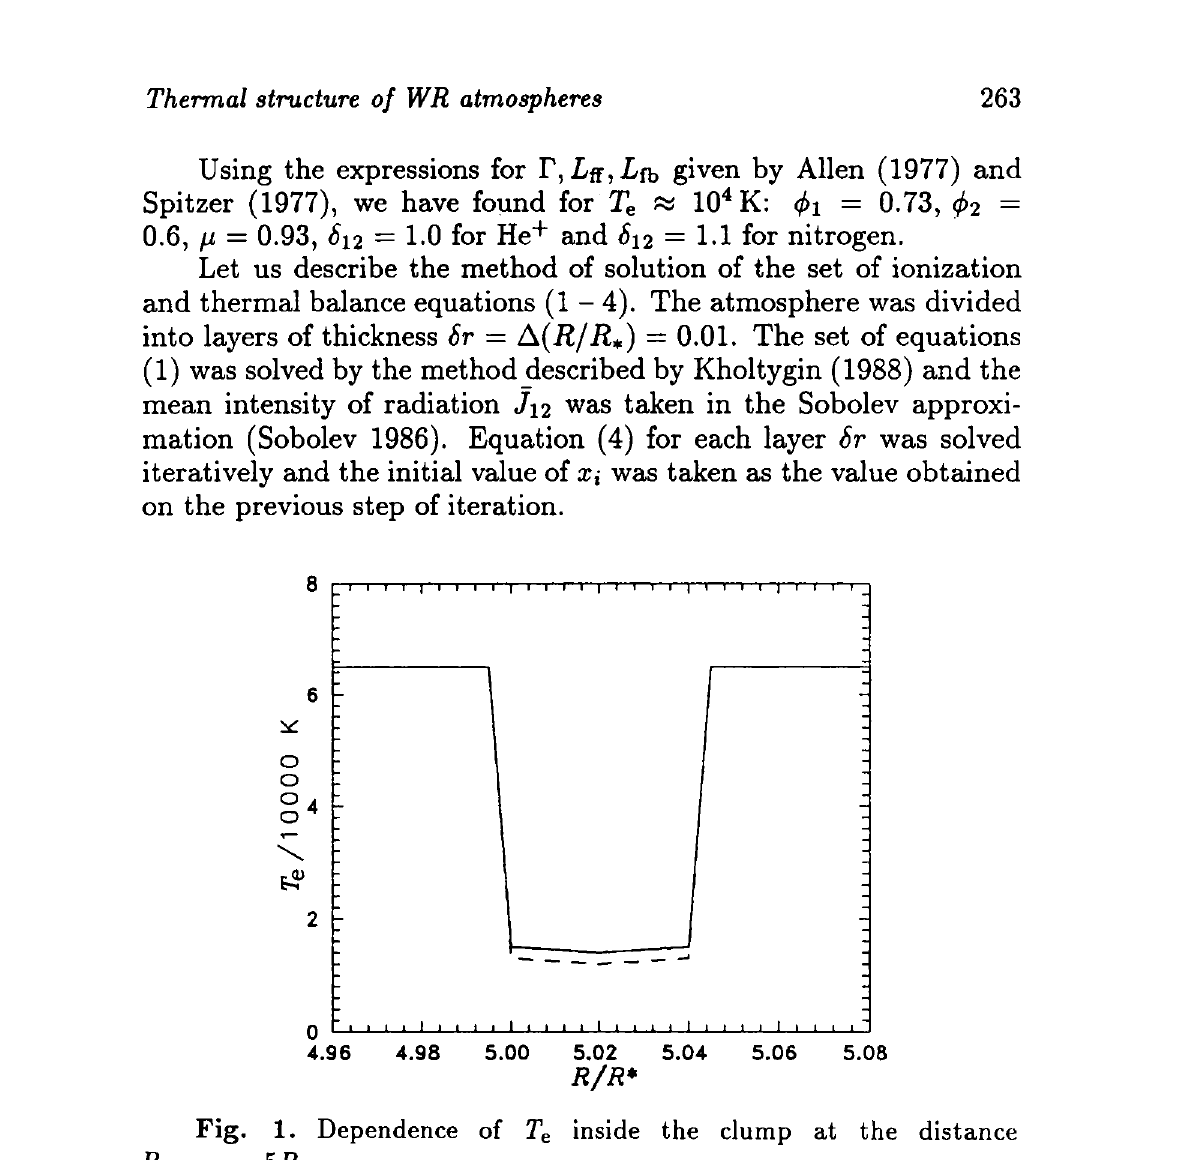
Fig. 1. Dependence of T e inside the clump at the distance ^clump =